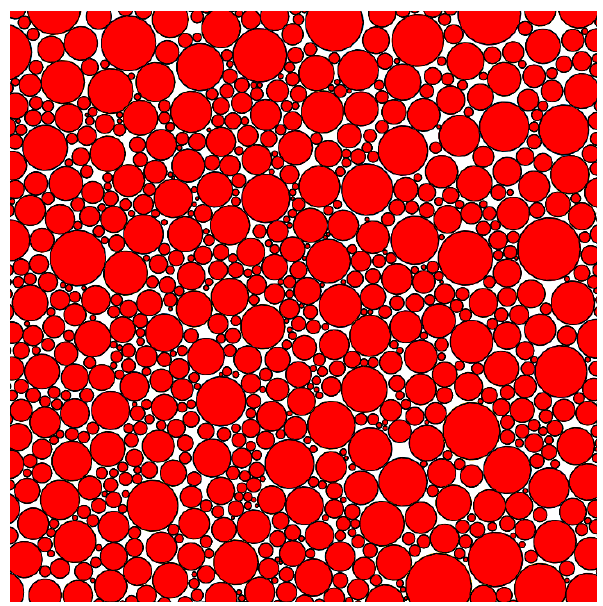
Figure 5. Powder bed packing pattern generated with 1000 powders. Table 2. Estimated powder bed void fraction with different powder number.